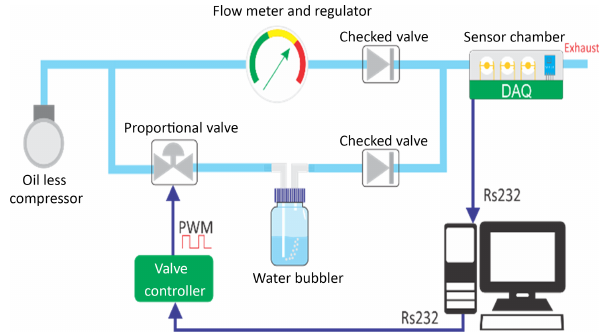
Figure 2. Schematic of the QCM humidity sensing configuration.